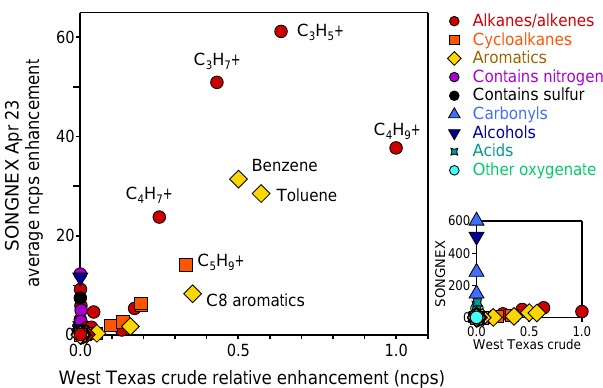
Figure 6. Comparison of H 3 O + ToF-CIMS measurement of VOCs over the Permian Basin to VOCs evaporated from west Texas crude oil. The values reported are the average boundary layer enhance- ment in signal (ncps) during the SONGNEX 23 April flight and the signal (ncps) relative to the most abundant mass ( m/z 57.070 ) in the west Texas crude oil C 4 H + 9